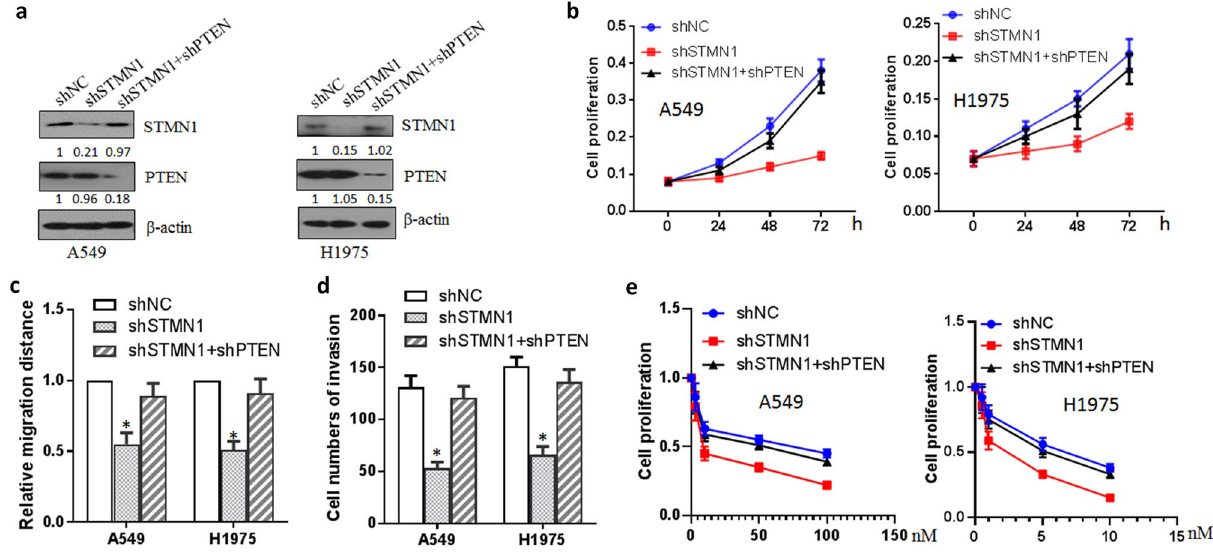
Figure 5. Effect of PTEN on the progression of lung cancer cells induced by STMN1. ( a ) Western blotting analysis of STMN1 in lung cancer cell A549 and H1975 transfected with STMN1 shRNA with or without PTEN shRNA plasmids. Full-length images are presented in Supplementary Fig. 11. ( b ) Cell proliferation was analyzed by CCK-8 kit in lung cancer cell A549 and H1975 transfected with the indicated plasmids. ( c ) Cell migration was analyzed by wound healing in lung cancer cell A549 and H1975 transfected with the indicated plasmids. * p < 0.05. ( d ) Cell invasion was analyzed by transwell in lung cancer cell A549 and H1975 transfected with the indicated plasmids. * p < 0.05. ( e ) Cell proliferation was analyzed by CCK-8 kit to determine the sensitivity of lung cancer cell A549 and H1975 to paclitaxel.